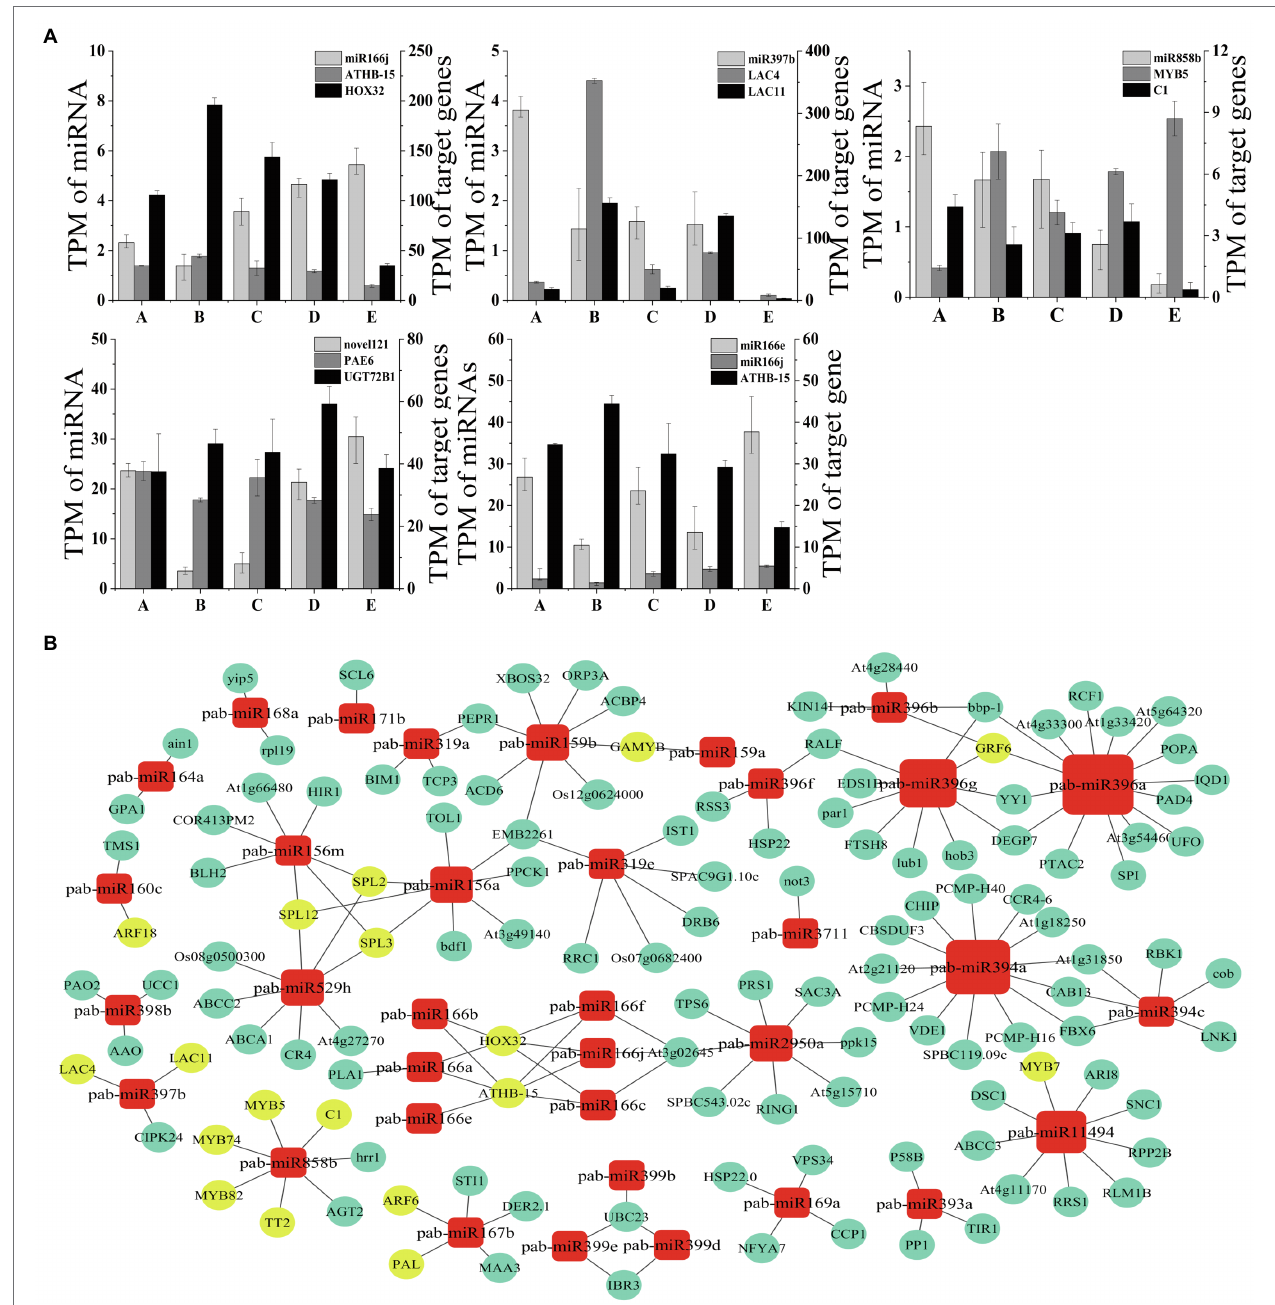
FIGURE 8 | (A) Correlations of miRNA and target gene expression levels during C. fortunei vascular cambium development. The x-axis presents the five stages, and the y-axes on the left and right present the TPM values of the miRNAs and their target genes, respectively. (B) MicroRNA regulatory network. The nodes represent single miRNAs and target genes. Circles represent target genes, and squares represent miRNAs; the larger the node is, the greater the number of miRNA target gene pairs